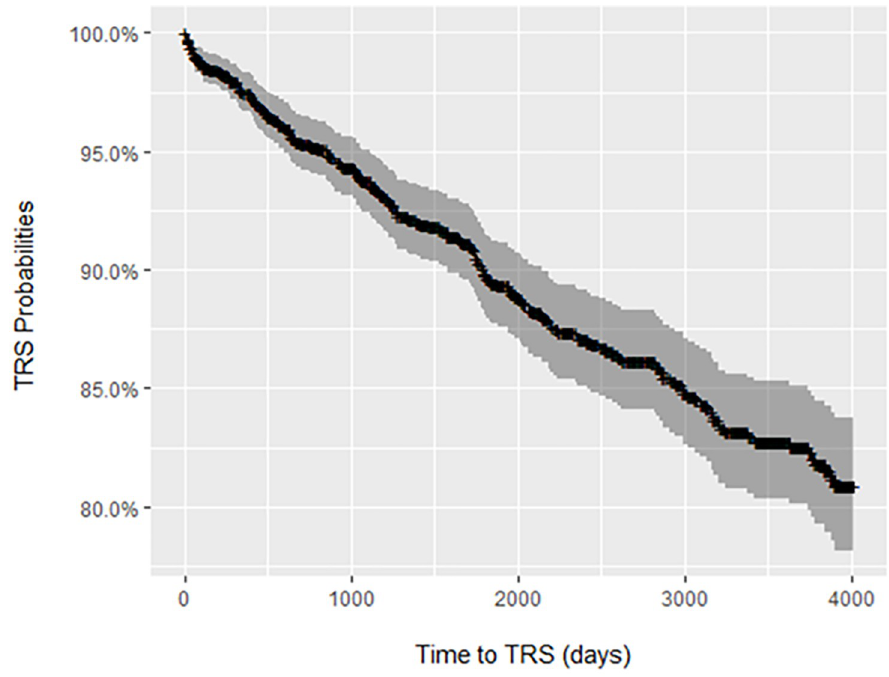
Fig 2. Kaplan-Meier curve of the survival probability for treatment resistant